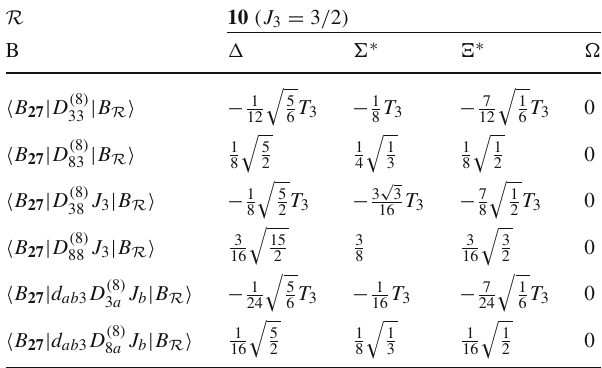
Table11 Therelevanttransitionmatrixelementsofthecollectiveoper- ators coming from the 27plet component of the baryon wave functions for the magnetic dipole form factors R